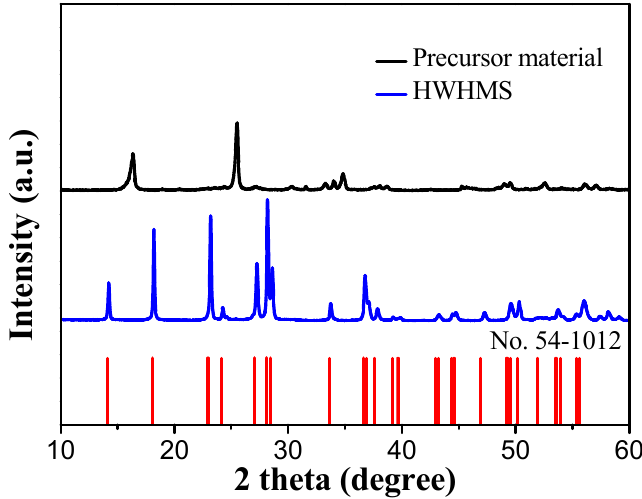
Figure 1. XRD pattern of as-synthesized HWHMS and the precursor material.